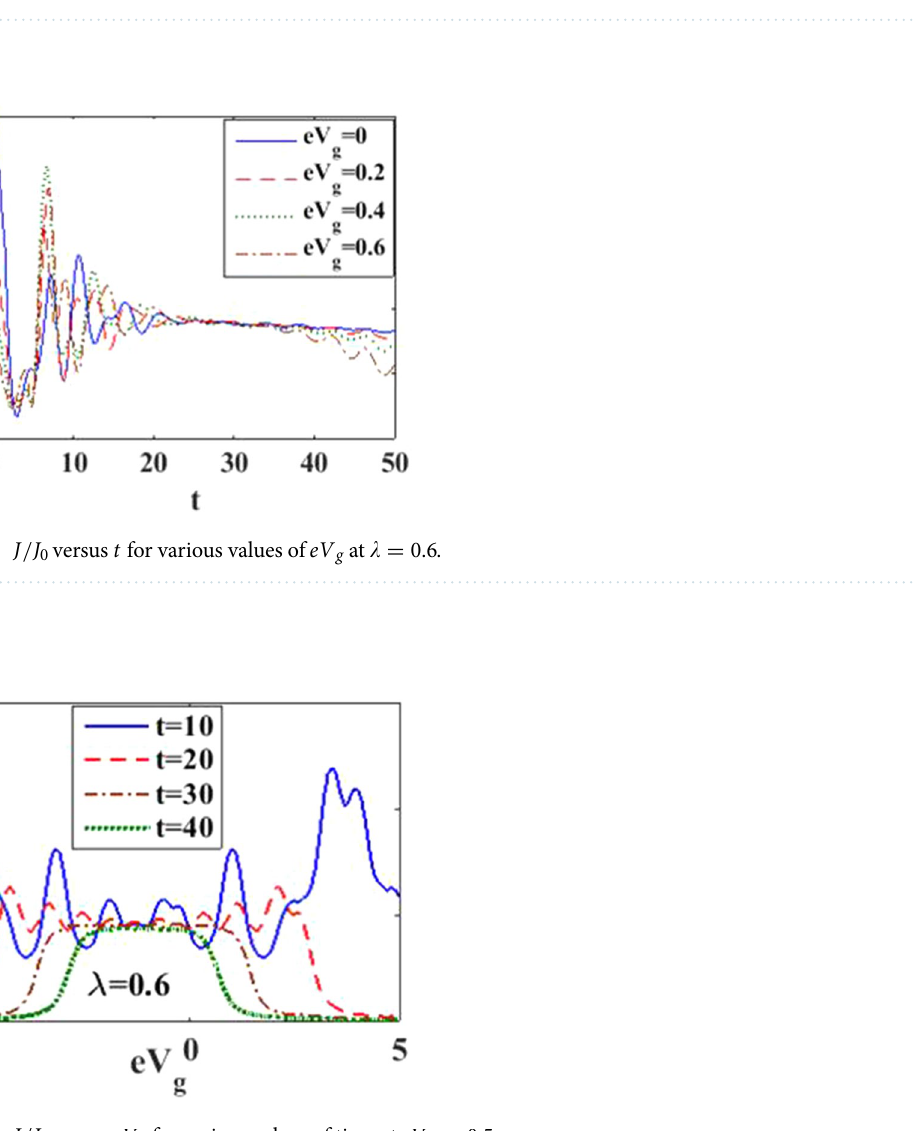
Figure 4. J / J 0 versus t for various values of damping rate at (cid:31) = 0.6 .